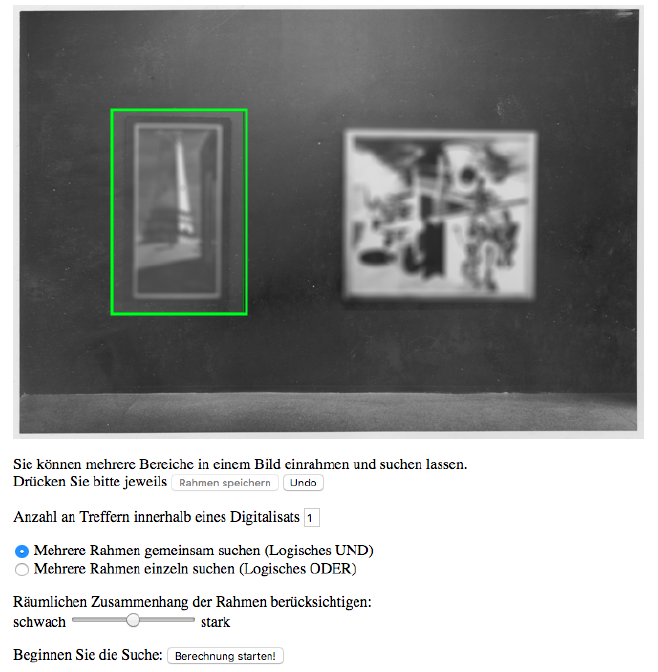
Figure 6. User’s selection of Giorgio de Chirico’s The Nostalgia of the Infinite on the Interface. As expressed in the region beneath, users can define, if the algorithm should search for both queries or also for single ones. Image rights: Computer Vision Group, Heidelberg University. Installation